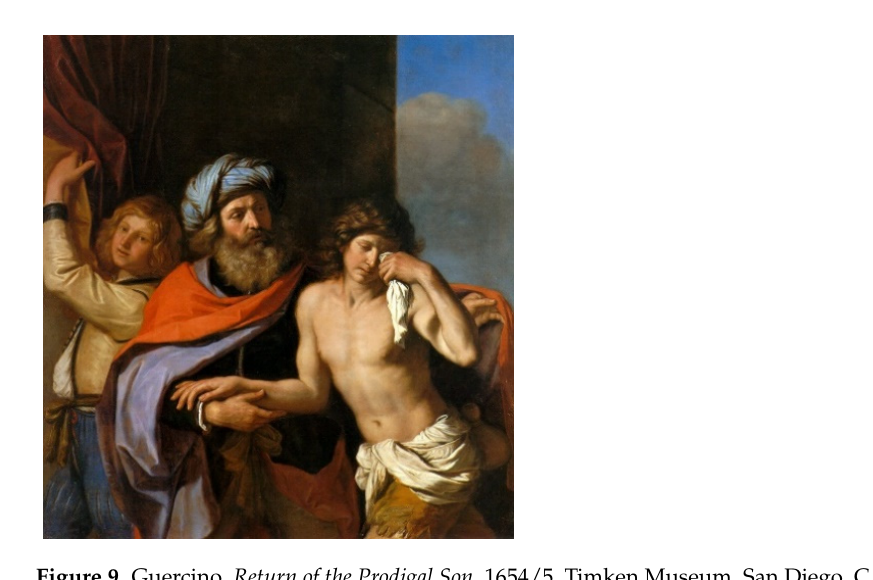
Figure 8. Guercino, Return of the Prodigal Son , 1651, Diocesan Museum, Wloclawek. Photo: Wikimedia Commons, Public Domain.